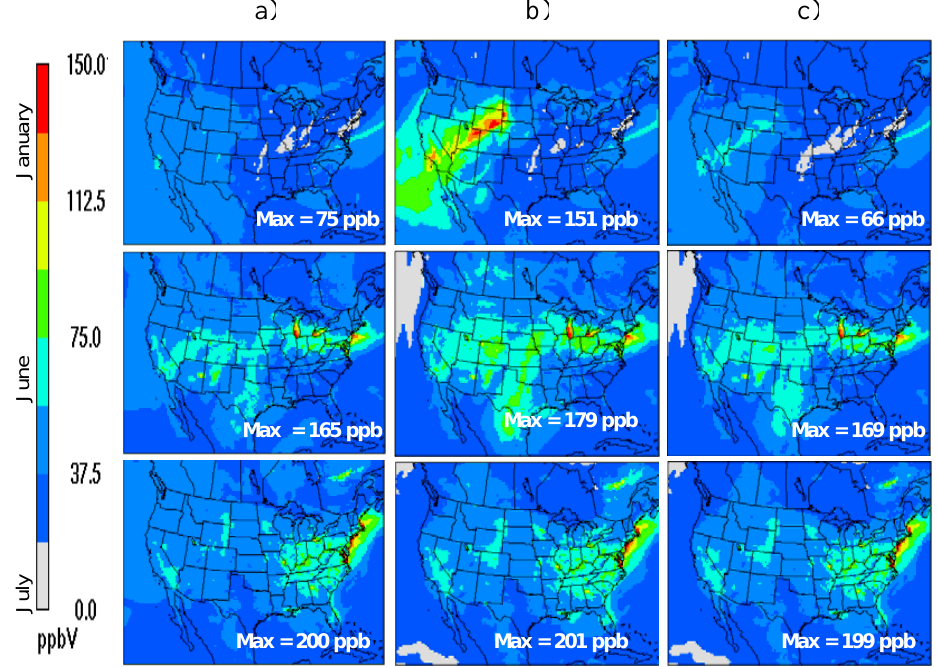
Fig. 10. Comparisons of monthly maximum 8-h surface ozone concentrations in January, June and July from CMAQ outputs; (a) Profile-BC (left), (b) ORDY-BC (middle), and (c) Tropo-BC (right). The maximum concentration within the domain is shown at the bottom of right hand corner.